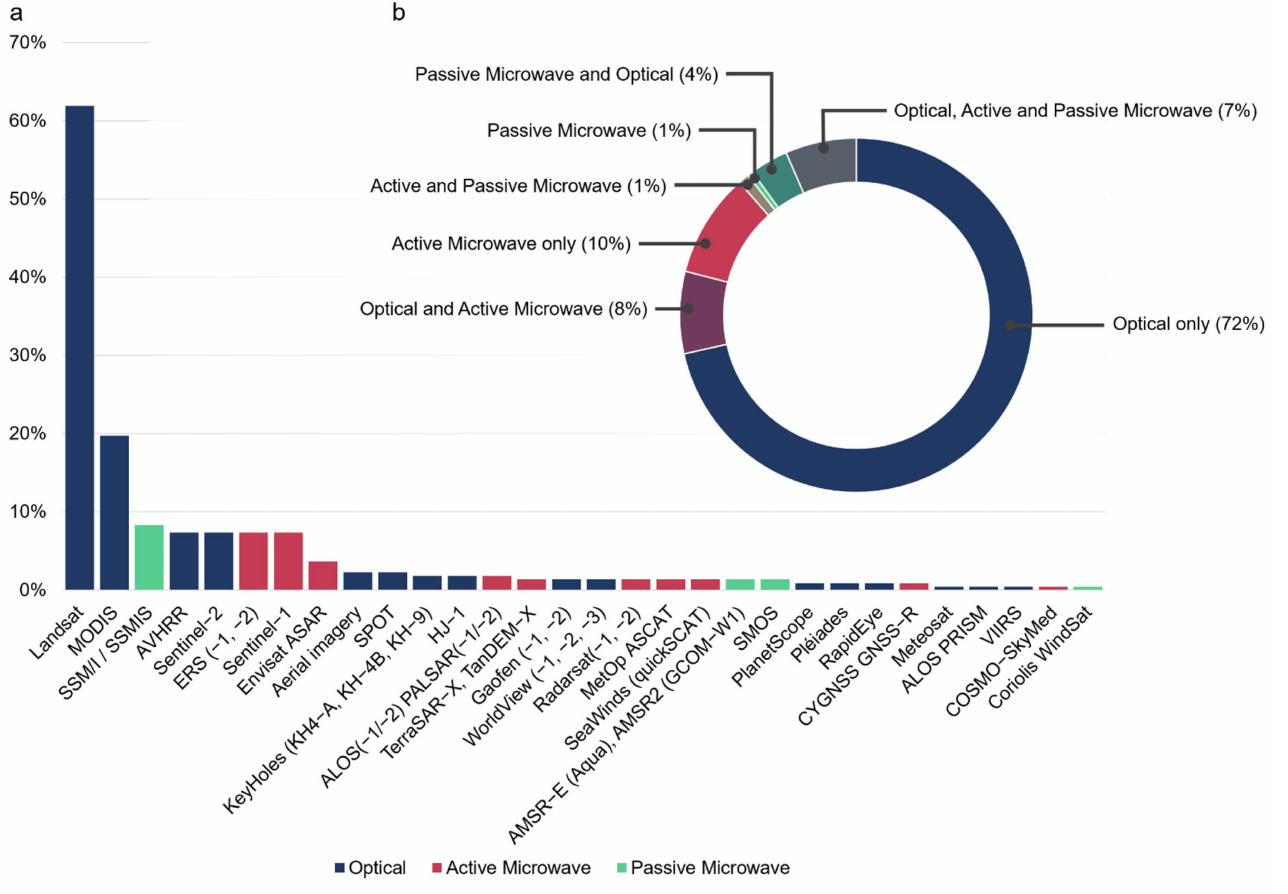
Figure 7. Used sensors ( a ) and sensor types ( b ) for surface water dynamics monitoring. Color coding indicates sensor type. Many studies use multiple sensors and sensor